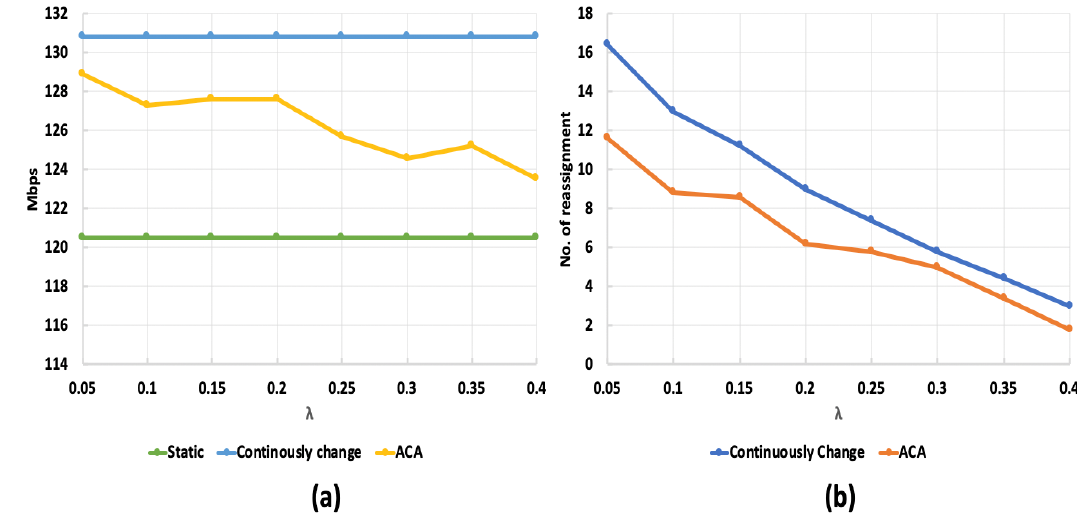
Figure 6. The network topology 2 results, the number of channel reassignments, and the overall throughput with the maximum two NICs, ( a ) throughput comparisons and ( b ) channel reassignment comparisons.